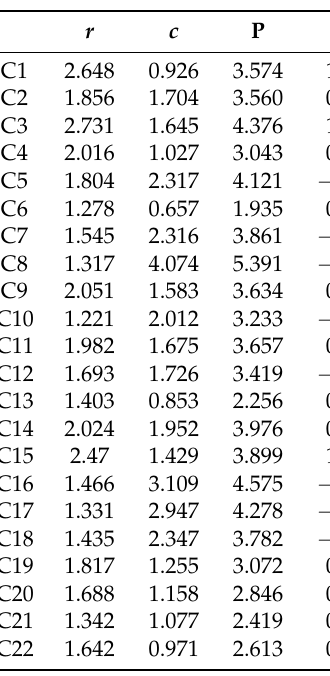
Table 8. Influences among risk factors and their relative weights in C